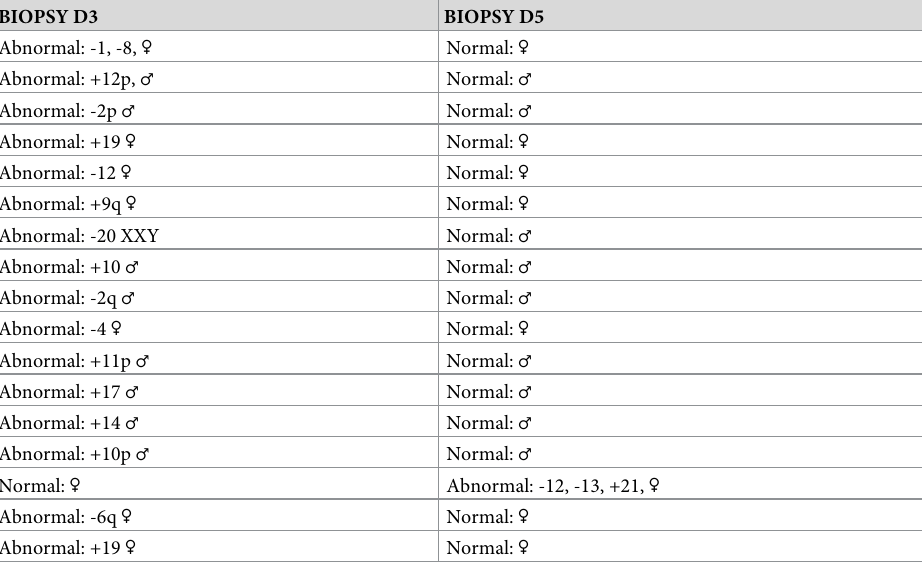
Table 4. Summary of the discrepancies per embryo diagnosis. BIOPSY